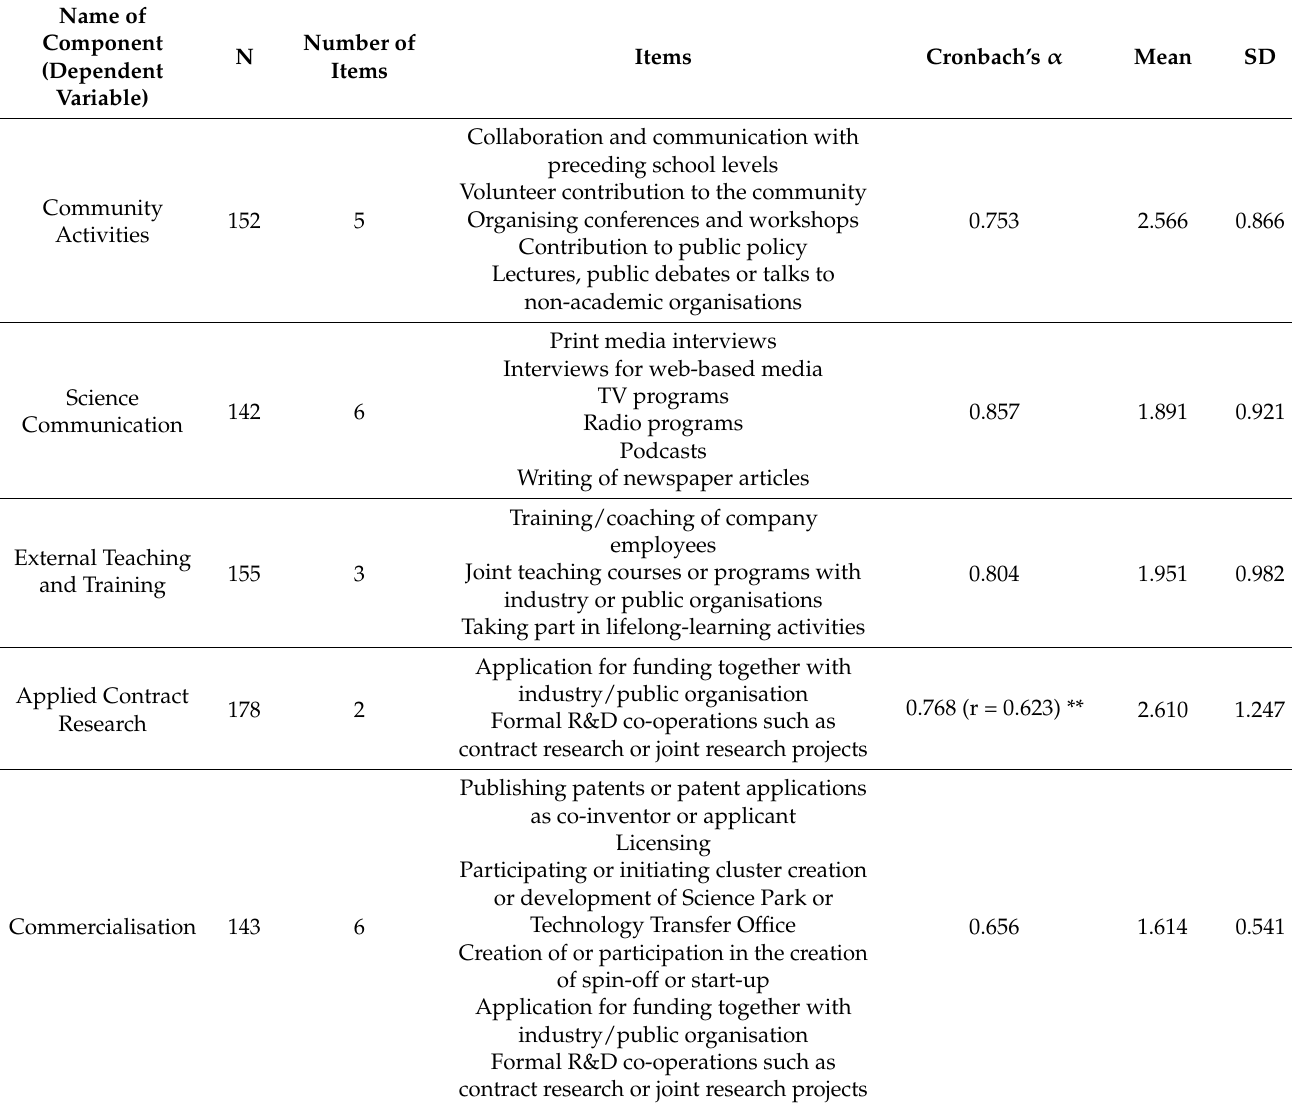
Table 2. Five components (dependent variables) of the Third